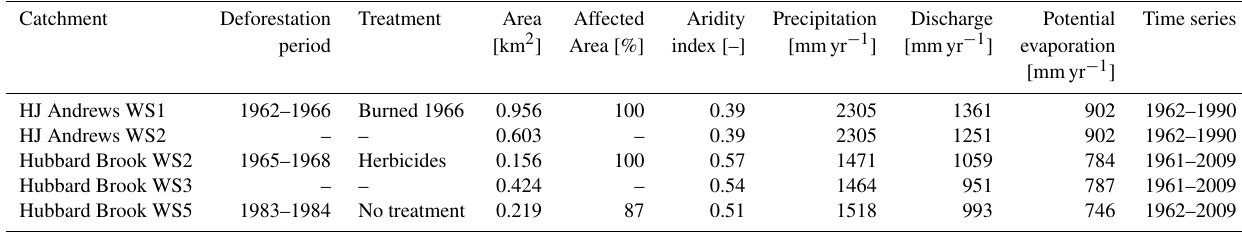
Table 1. Overview of the catchments and their sub-catchments (WS).